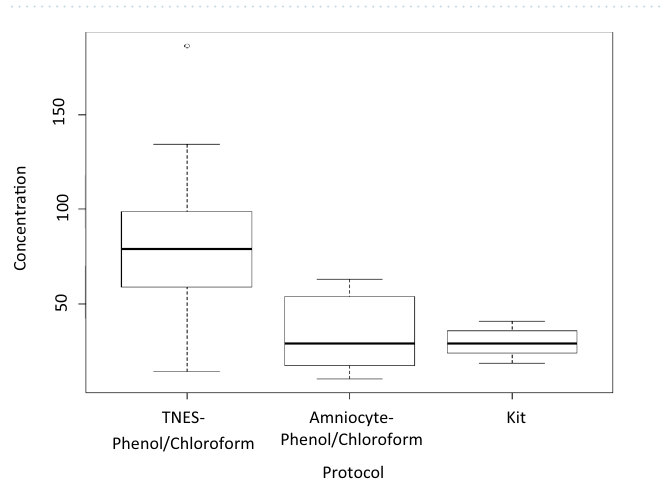
Figure 4. Box plots of the concentration of genomic DNA following extraction using three different extraction techniques with incubation at 42 °C for 12 h.